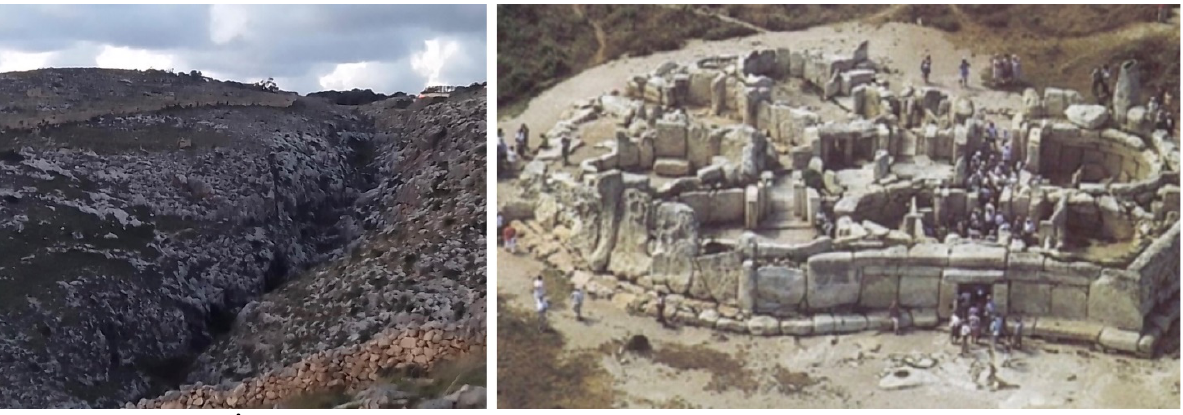
Figure 5. Wied iż - Żurrieq , one of the pristine, ecologically rich, valleys in Malta (left); dated aerial photo of Ħa ġ ar Qim Neolithic Temples (right) ( Hagar Qim by peuplier is licensed under CC BY 2.0 ) [26], (online version is in